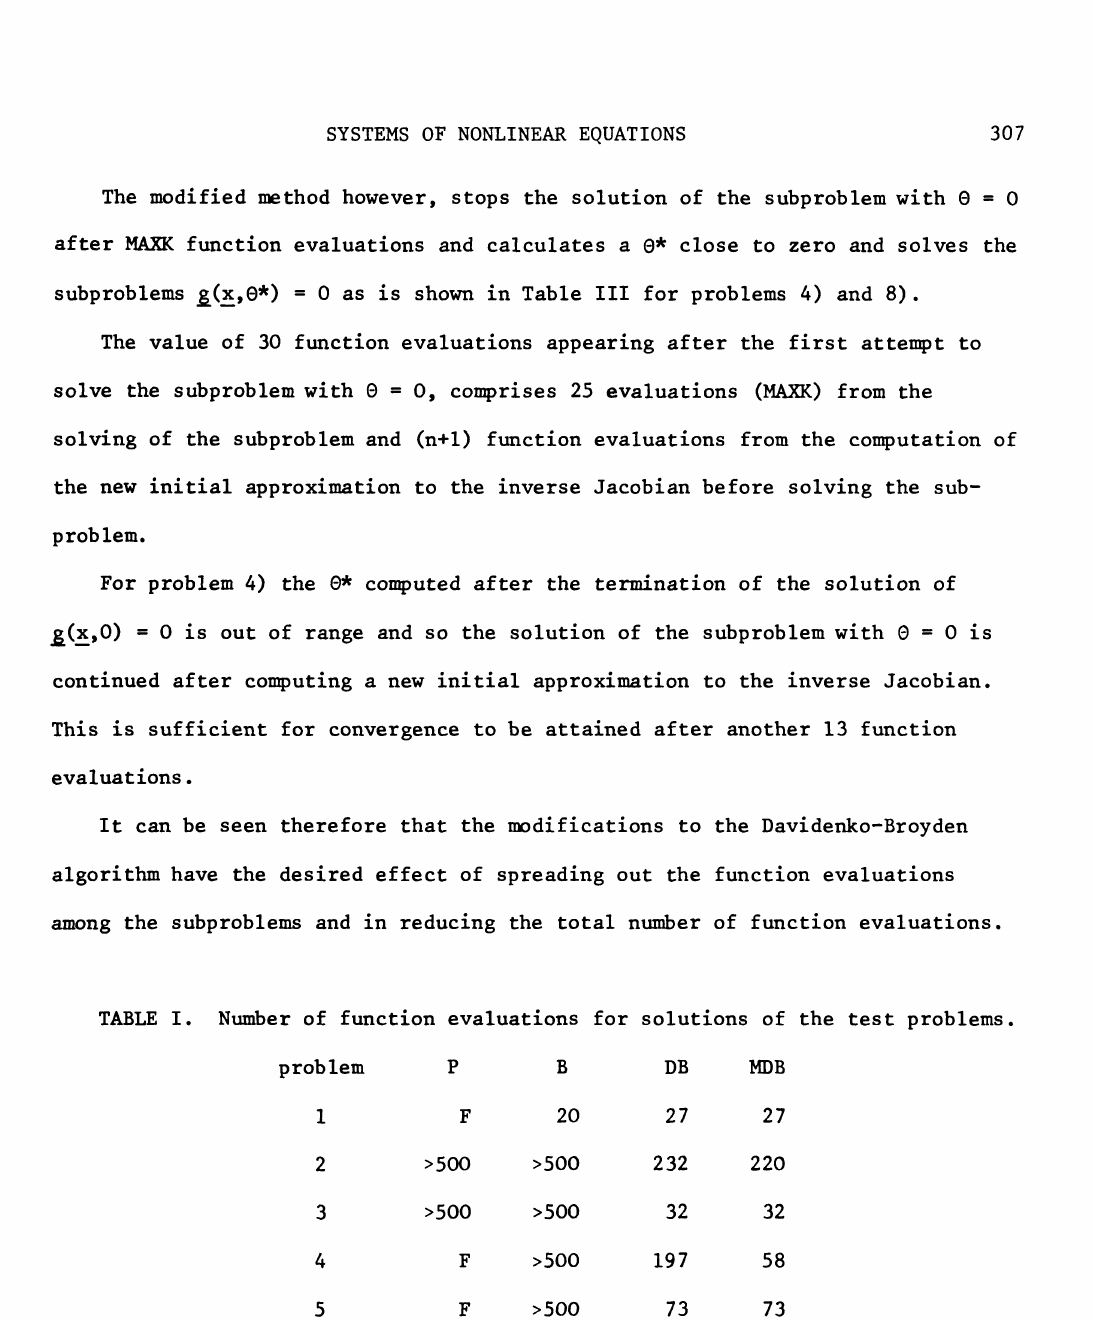
Number of function evaluations for solutions of the test